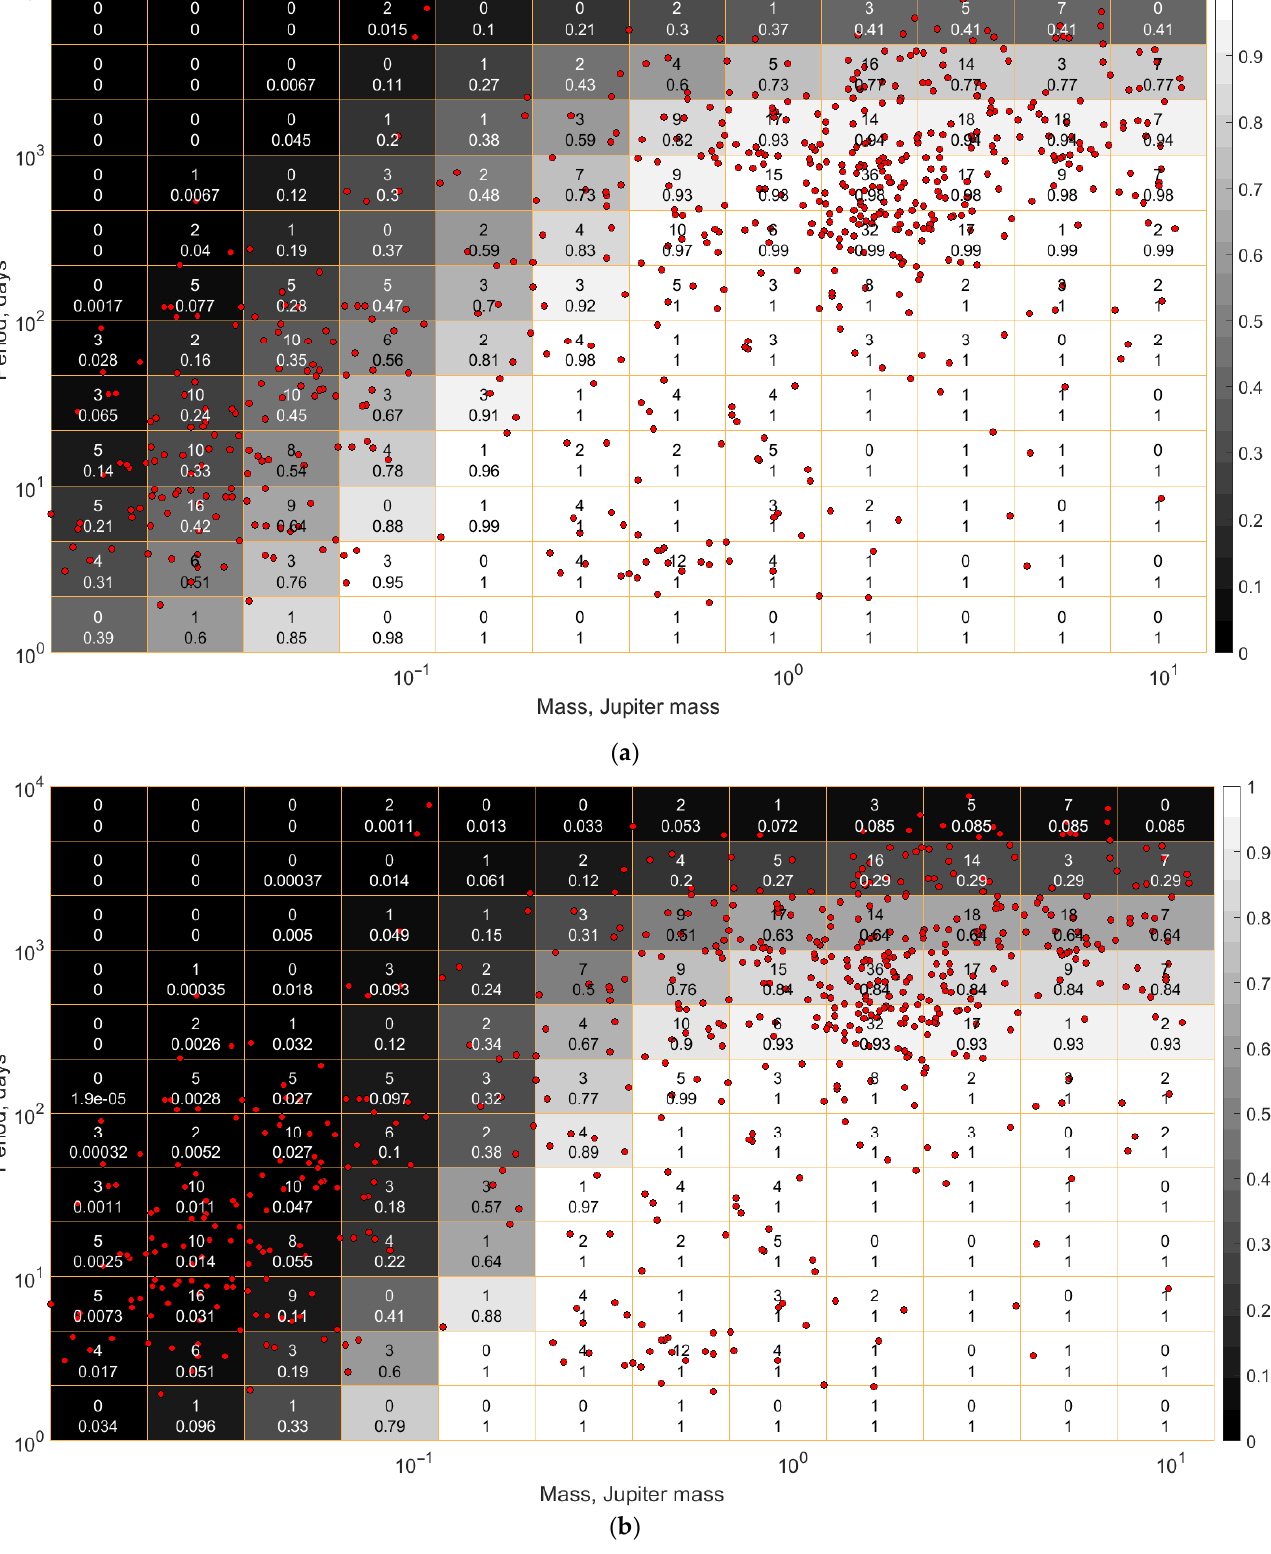
Figure 2. The detectability windows: ( a ) W (for multiplanet systems) and ( b ) V (for stars with and without planets) in the format of maps in the m – P plane obtained with the coefficients γ = 0.8 and δ = 2.0. The designations are the same as those in Figure 1.